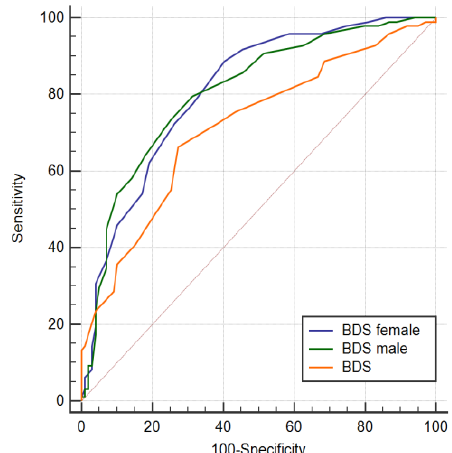
Figure 2. Receiver operator characteristic (ROC) curves of the bio depression score obtained from the combined active serum and urine biomarkers determined with the quantile-based prediction with and without gender stratification and after randomization. AUC BDS = 0.739 (sensitivity = 74%, specificity = 66%) with 22 contributing biomarkers, AUC Male = 0.807 (sensitivity = 80%, specificity = 69%) with 26 contributing biomarkers and AUC Female = 0.806 (sensitivity = 89%, specificity = 59%) with 22 contributing biomarkers.